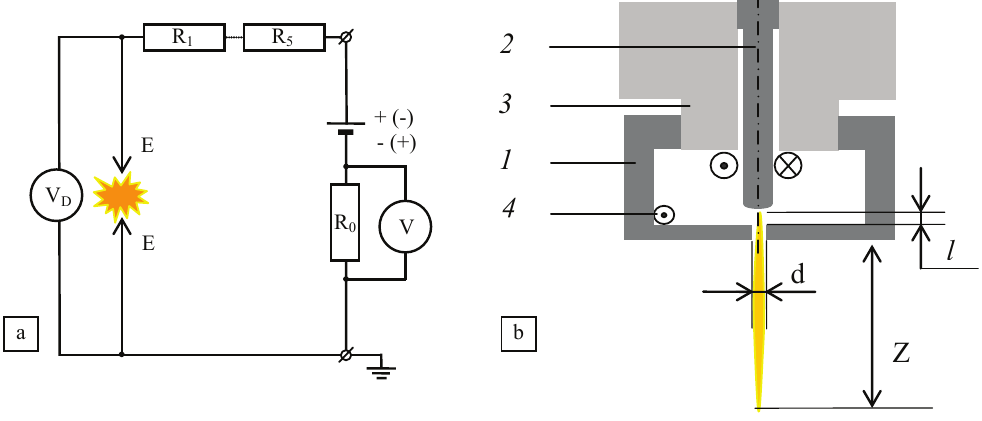
Figure 1: Microdischarge system with vortex gas flow: a- electrical schema; b- electrodes geometry (1, 2 – electrodes, 3 – Teflon dielectric, 4 – gas inlet, d – the outlet diameter, l – distance between electrodes, Z – plasma jet